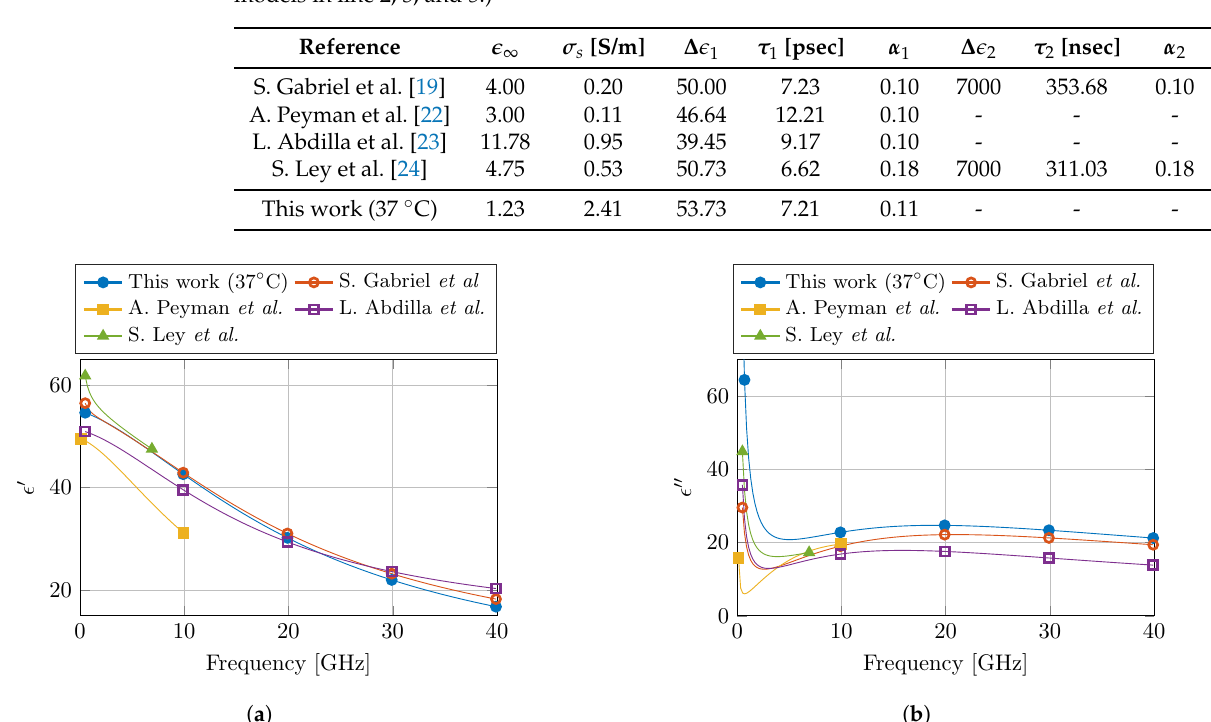
Table 2. Overview of the Cole–Cole parameters for muscle tissue at 37 ◦ C compared with the ones